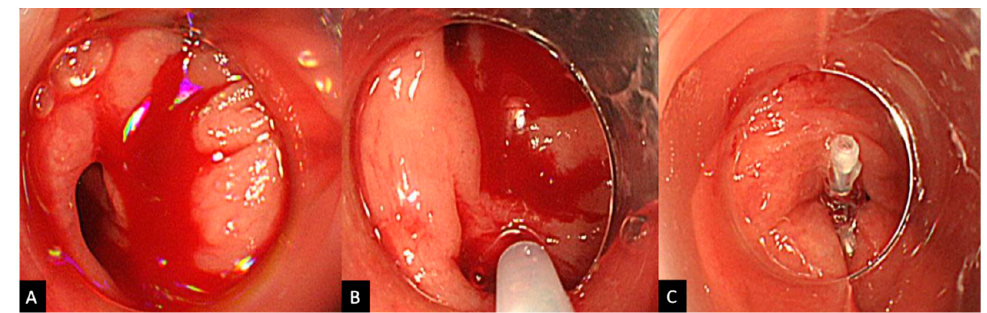
Figure 2. ( A ) Endoscopic view of active bleeding from a diverticulum. ( B ) Local injection of epinephrine administered around the neck of the bleeding diverticulum. ( C ) Primary hemostasis achieved after direct clipping.